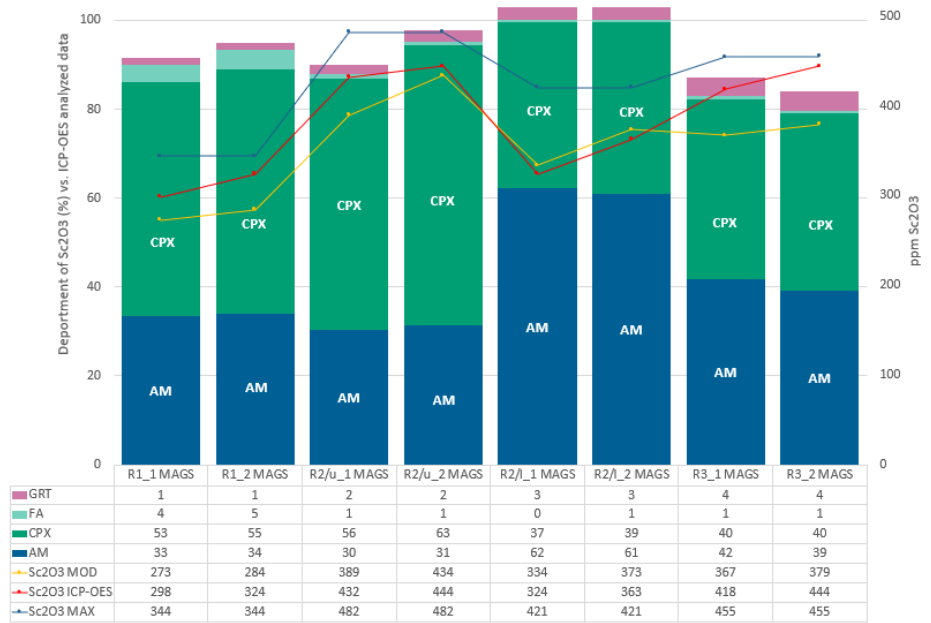
Figure 11. The deportment of Sc 2 O 3 in combined LIMS + SLon concentrates (MAGS) according to modal mineralogy in comparison to ICP-OES data. Corresponding SLon parameters are 1 = 50 rpm and 0.5 T; 2 = 150 rpm and 1.0 T. Sc 2 O 3 MOD = Sc 2 O 3 content based on modal mineralogy and EPMA results; Sc 2 O 3 ICP-OES = analyzed with ICP-OES; Sc 2 O 3 MAX = theoretical maximum grade for ferro- and paramagnetic concentrate based on modal mineralogy.